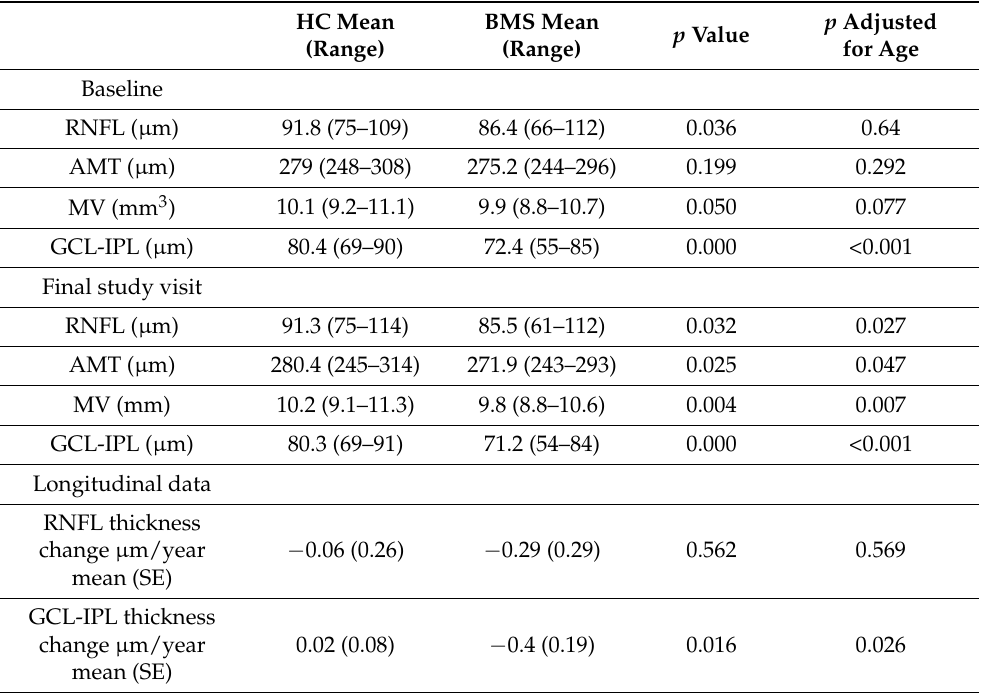
Table 3. OCT measures of all eyes of BMS and HC groups.